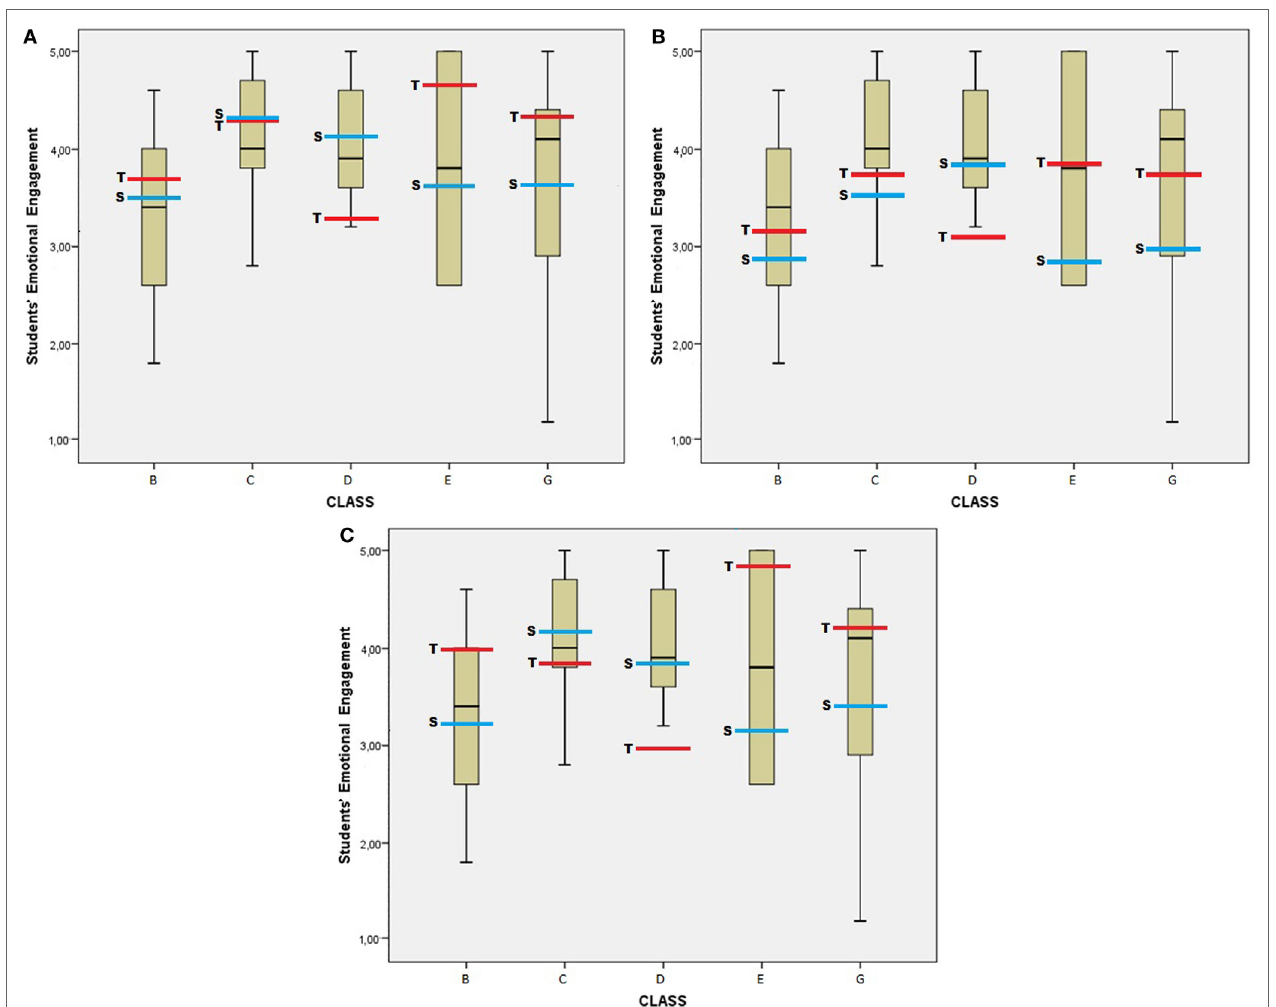
FigUre 5 | Students’ emotional engagement, teacher-provided and student-perceived (a) structure, (b) autonomy support, and (c)